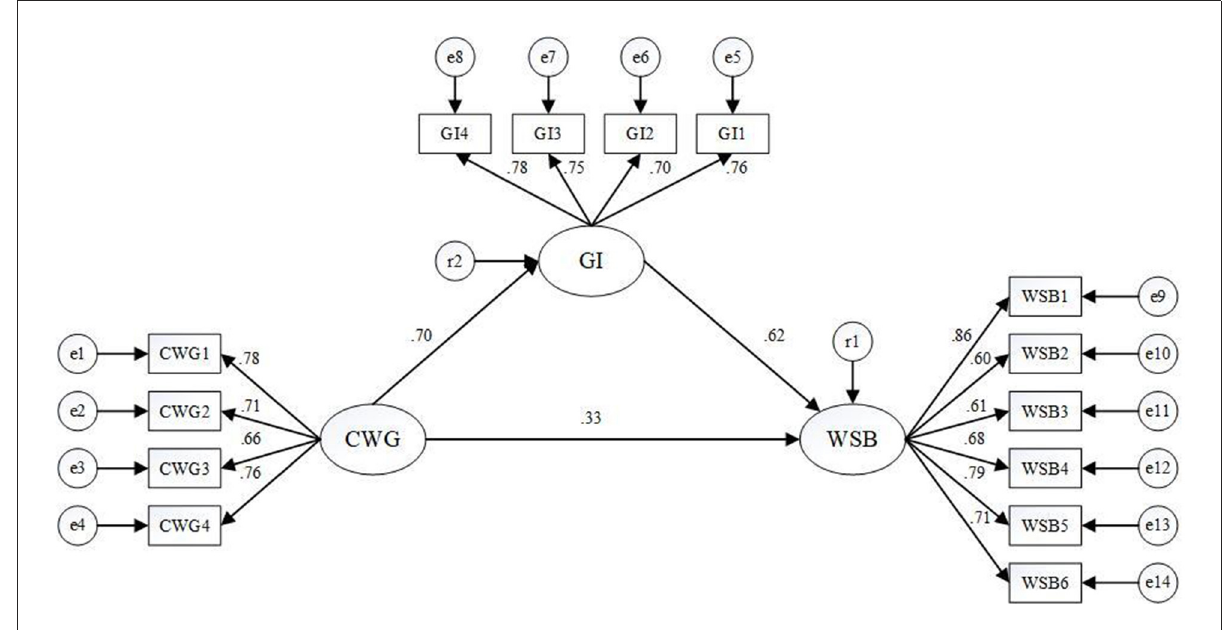
FIGURE2 Hypotheses testing